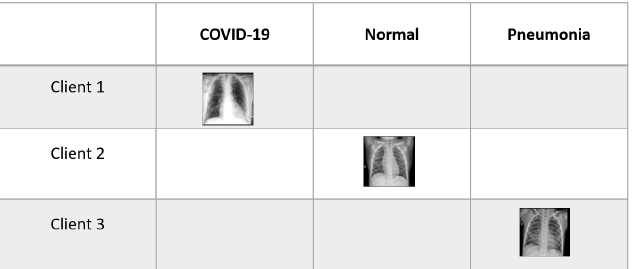
Figure 9. An illustrative example of imbalance size for chest X-ray data with three clients and k =